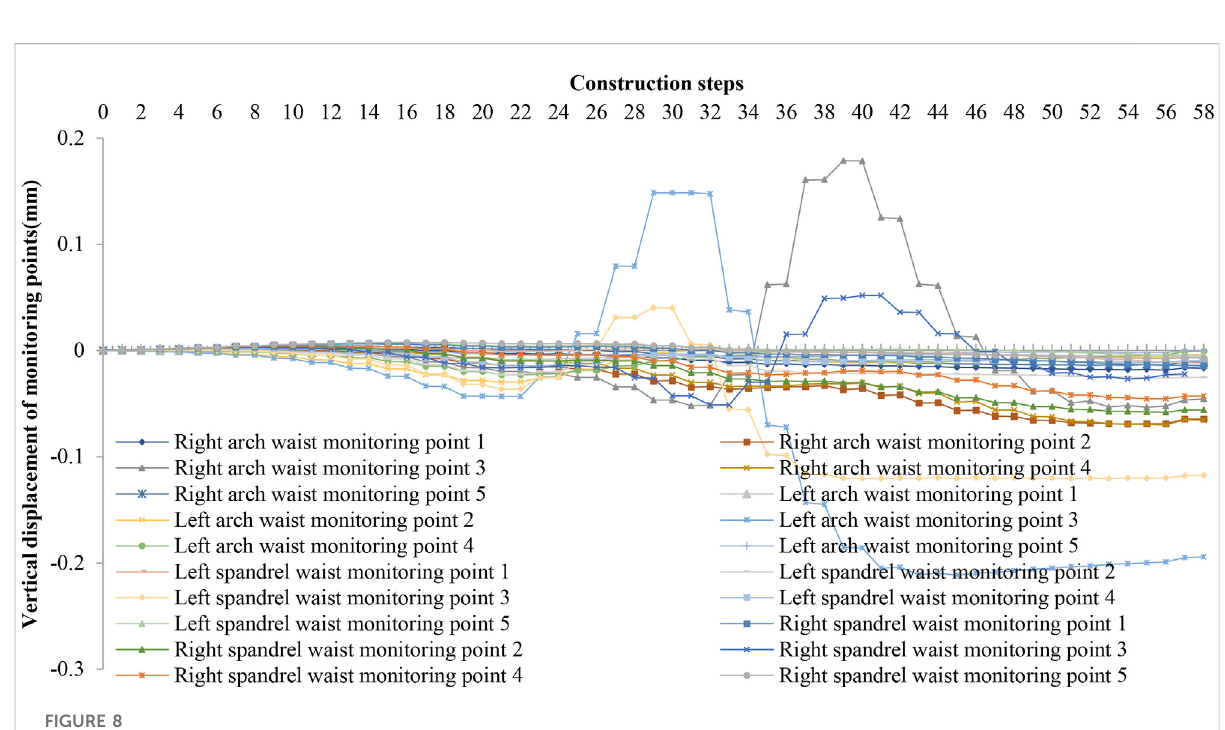
FIGURE 8 Horizontal displacement of the left tunnel monitoring